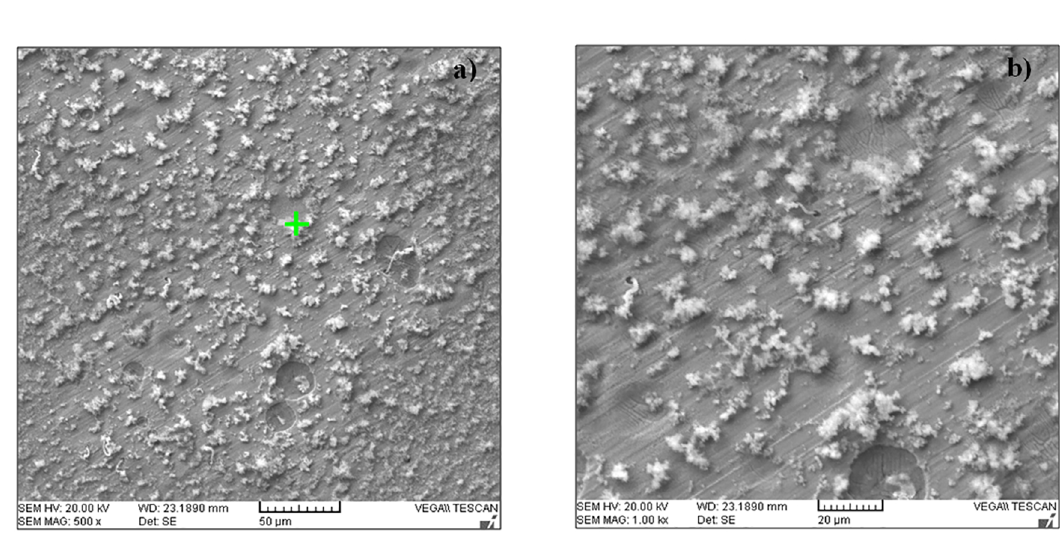
Figure 15. SEM of the 28% manganese steel corrosion products in aqueous solution 0.1M NaCl. Source: